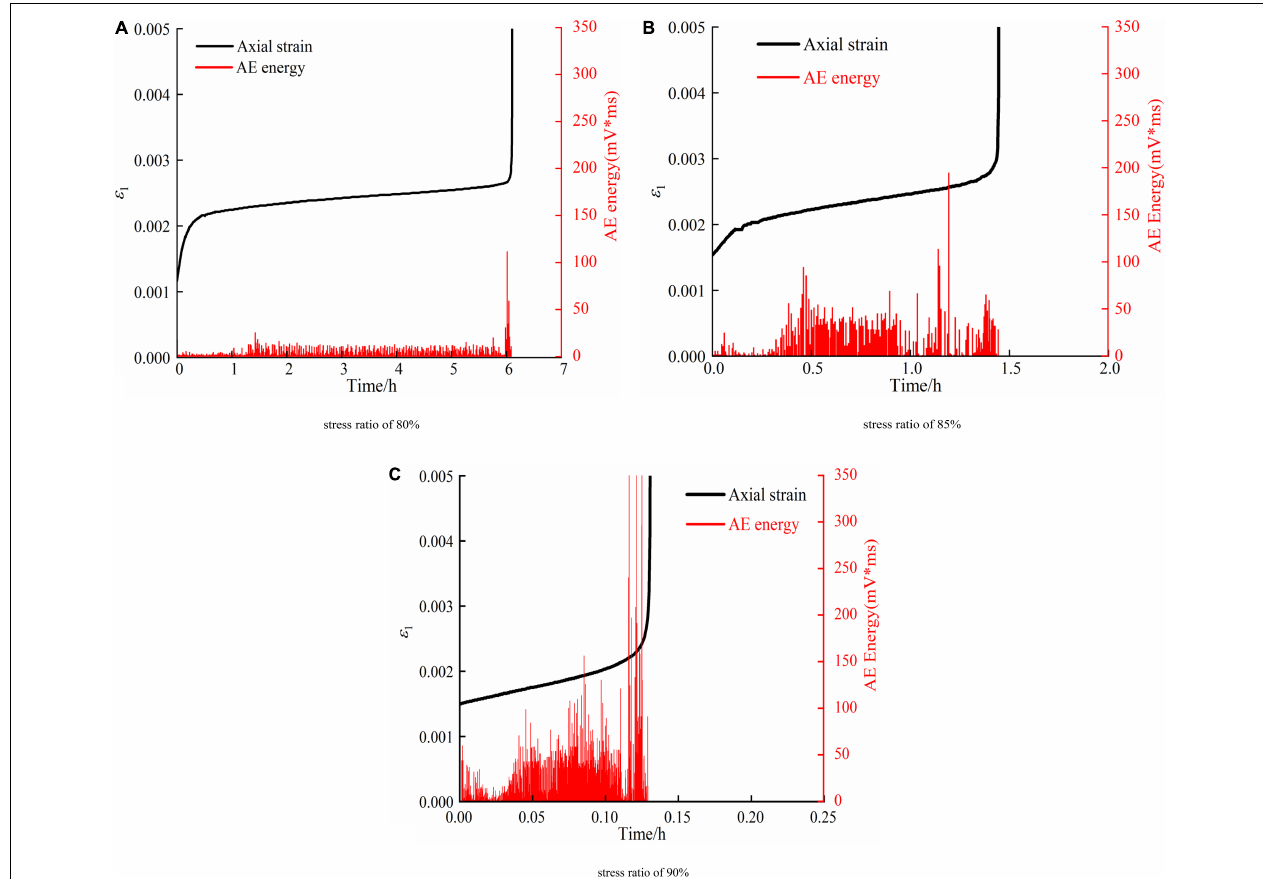
FIGURE 9 | Instantaneous AE energy plotted with time under the confining pressure of 2.5 MPa. (A) Stress ratio of 80%. (B) Stress ratio of 85%. (C) Stress ratio of